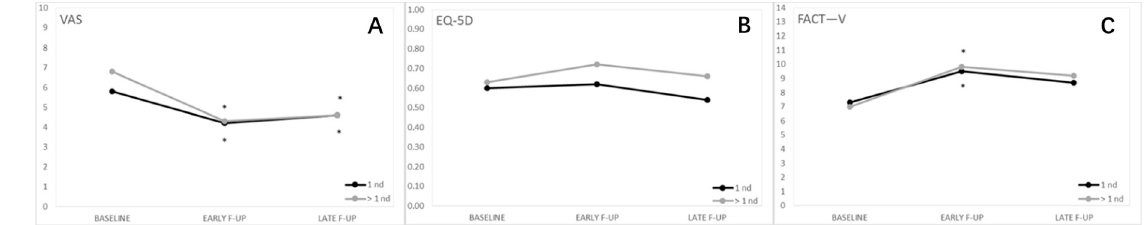
Figure 4. Quality of life by number of lesions. ( A ) Visual analog pain scale (VAS); ( B ) Functional Assessment of Cancer Therapy—Vulva cancer (FACT-V); ( C ) EuroQol 5-Dimension 5-Level (EQ-5D). The number of lesions does not impact QoL *